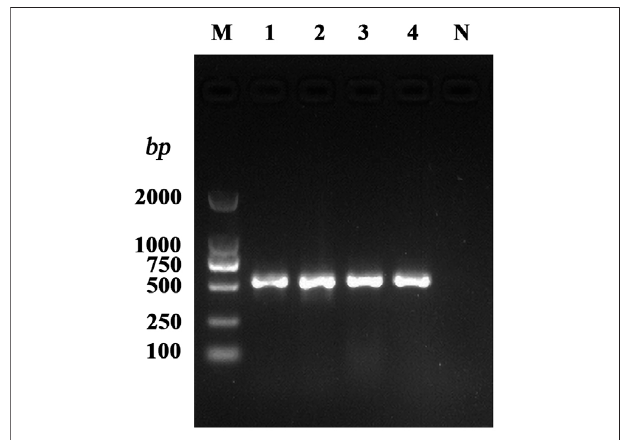
FIGURE 1 | PCR ampli fi cation of the S. aureus virulence gene. Note: M: DL2000 DNA Marker; 1 – 4: test strains; N: negative